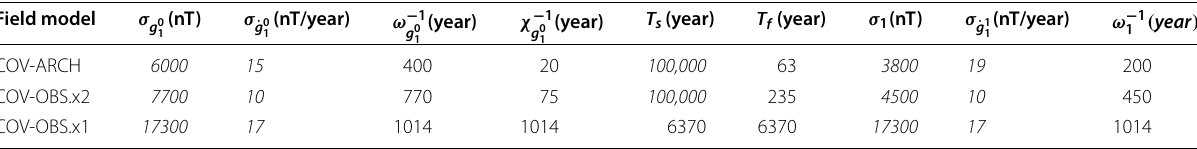
Table 1 Parameters used for the AR-2 processes describing the statistics of axial and equatorial dipoles in the construction of COV-OBS.x2, compared with those used for the COV-ARCH model of Hellio and Gillet (2018), and the earlier editions COV-OBS.x1 (Gillet et al. 2015)